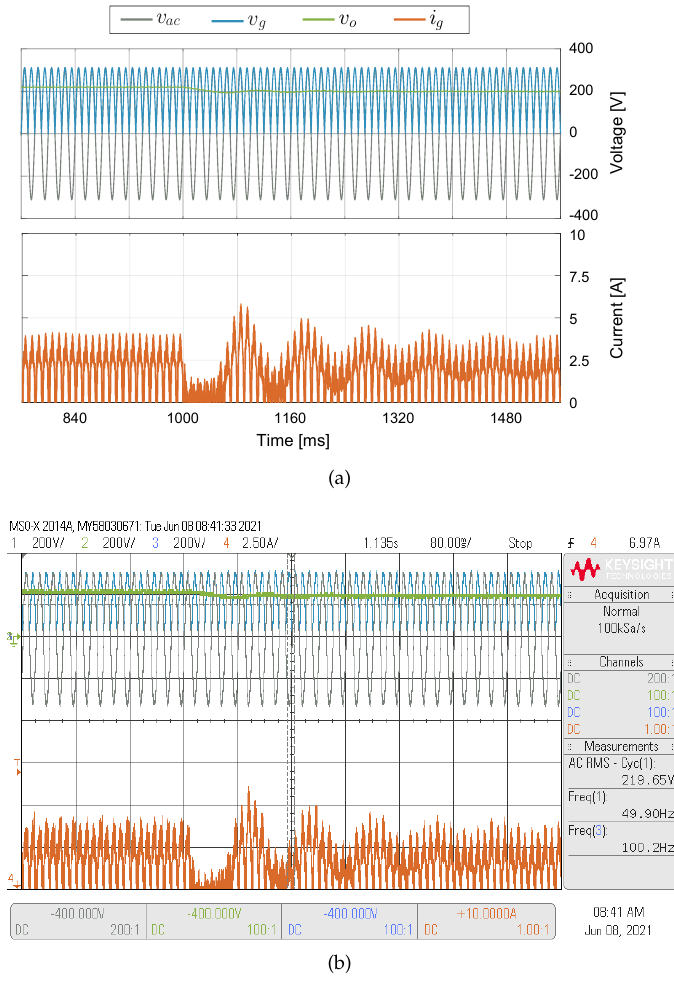
Figure 12. Simulated ( a ) and experimental ( b ) dynamic behavior of the double loop when the reference v oref changes with steps of 20 V from 220 V to 200 V. CH1: v ac (200 V/div), CH2: v o (200 V/div), CH3: v g (200 V/div), CH4: i g (2.5 A/div) and a time base of 80 ms.